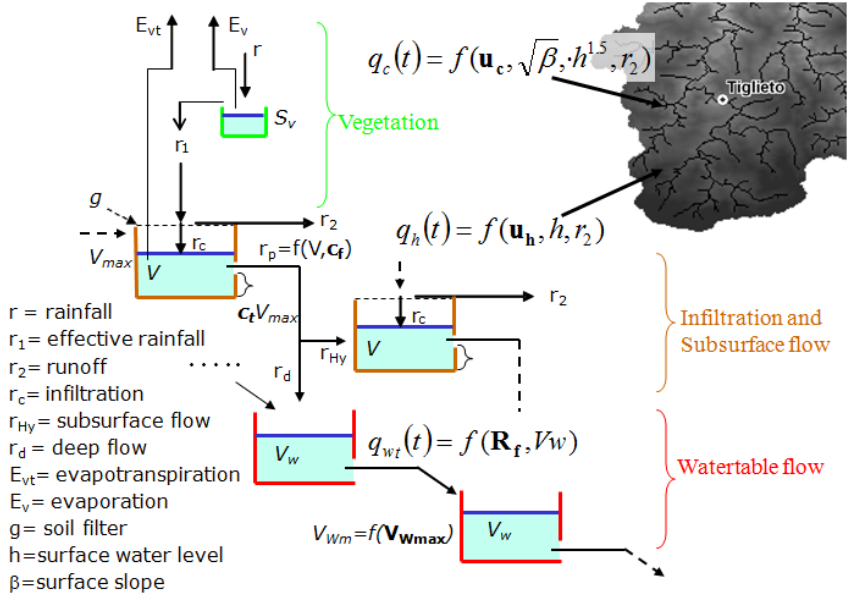
Figure 1. Representation of the different processes described in Continuum model and how different cells are connected. Surface flow is described by nonlinear and linear motion equations, respectively, on channels ( q c ) and hillslopes ( q h ). Two consecutive cells are represented, each cell has the x and y dimensions that correspond with the spatial resolution of the